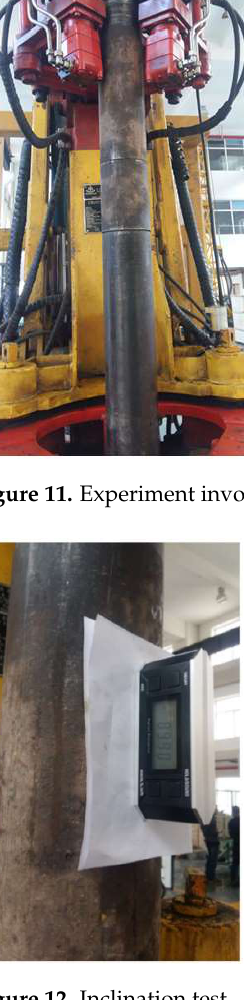
Table 4. Position deviation of the drill pipe and spin condition of the spinner mechanism with single follow-up